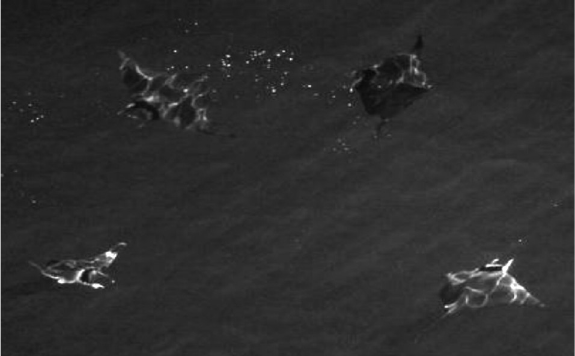
Fig. 2. – Four giant devil rays encountered in the southern Adriatic